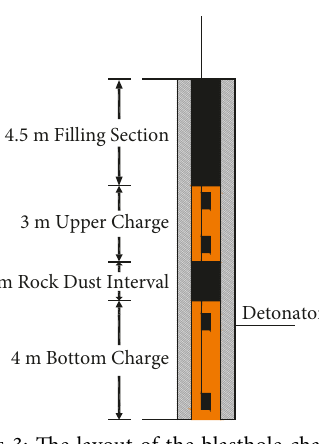
Figure 3: The layout of the blasthole charge.